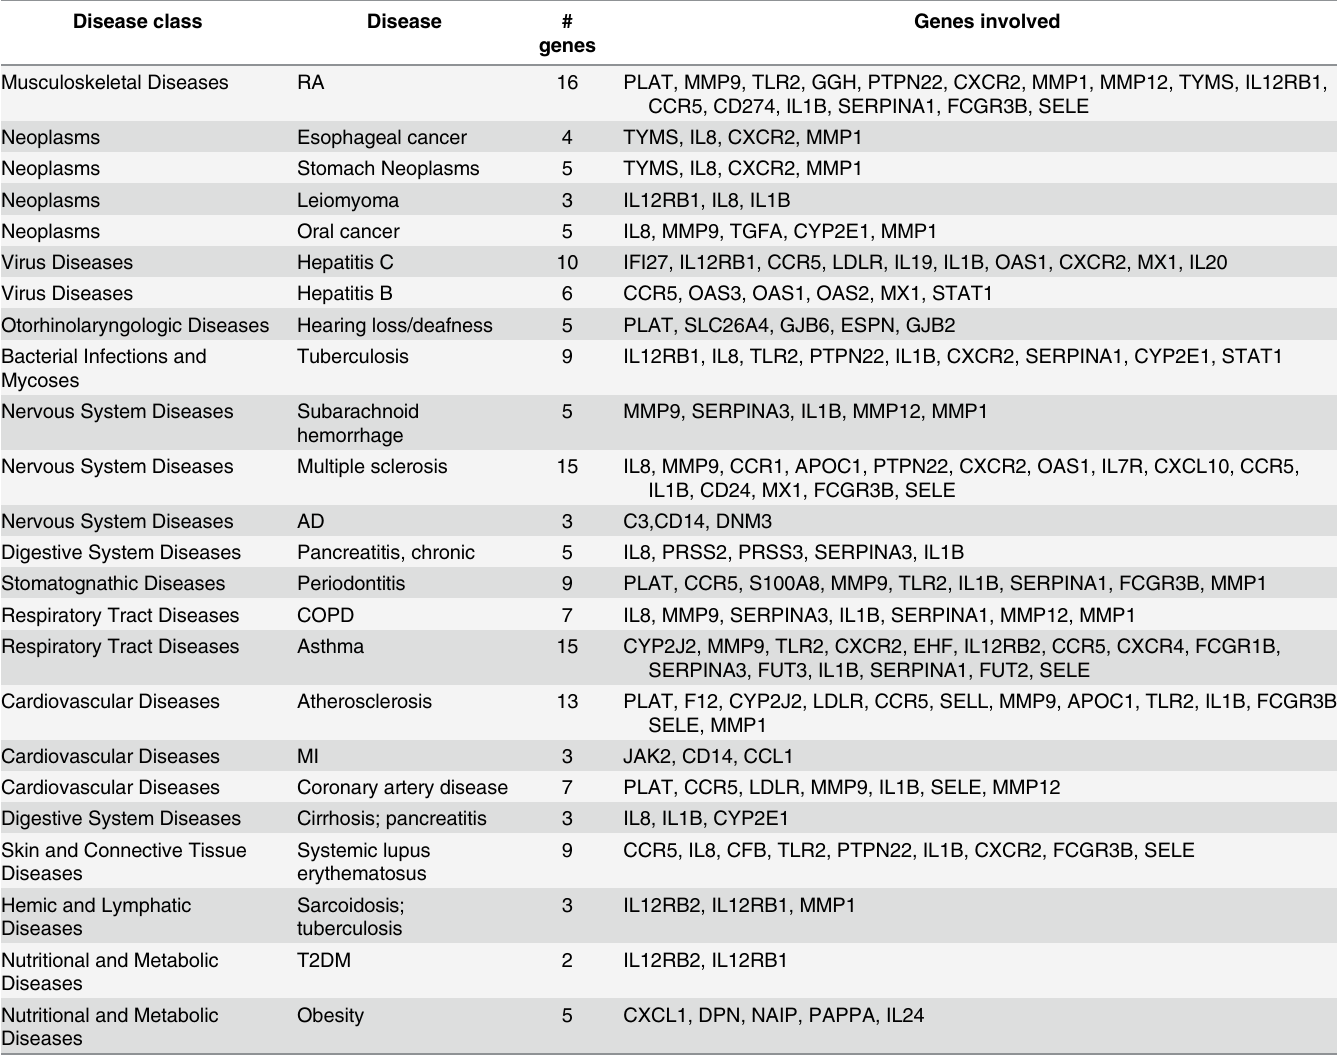
Table 2. Disease categories associated with psoriasis based on the genes